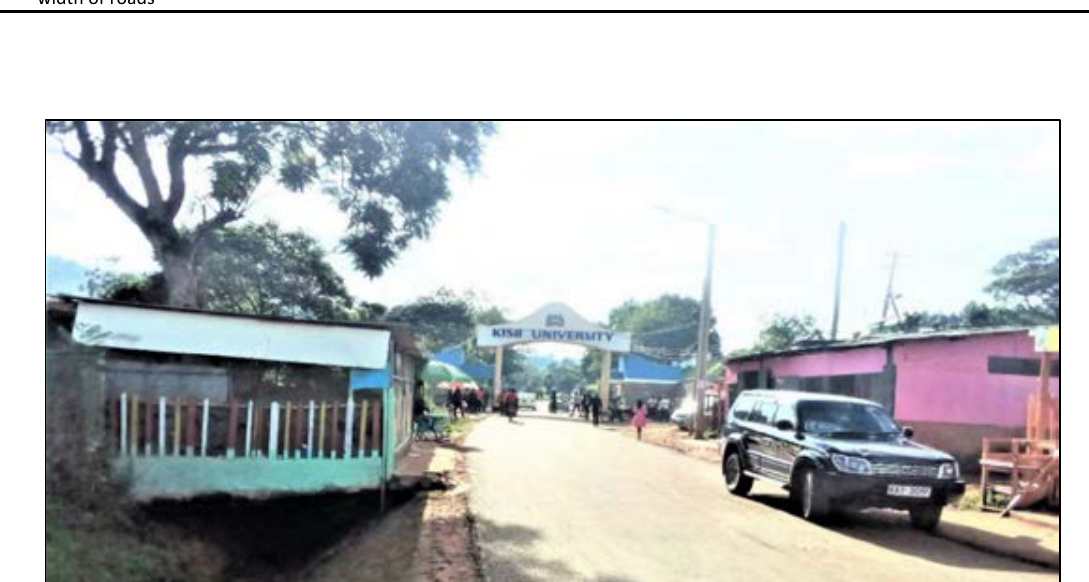
Paired samples Observed widths of the road vs Recommended width of roads